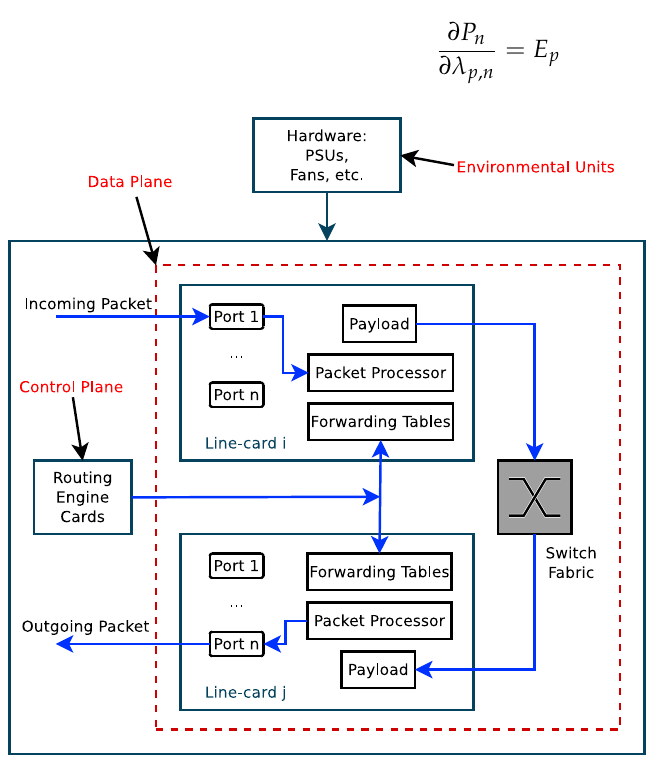
Figure 21. A structure of a Core Router or Switch